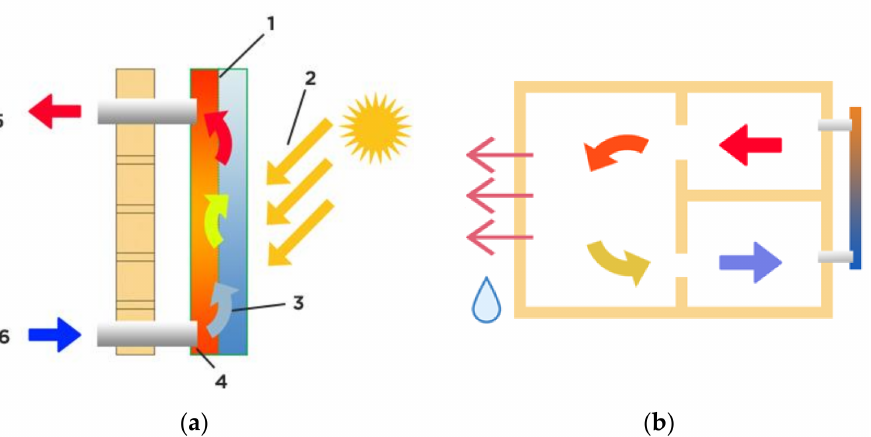
Figure 2. Application of air solar collectors in the oil and gas field in subarctic conditions: ( a ) scheme of air heating from solar radiation, ( b ) diagram of the movement of air mass in the room, 1—heated part of the solar collector, 2—incident solar radiation, 3—cold part of the solar collector, 4—air channel, 5—heated indoor air, 6—cold indoor